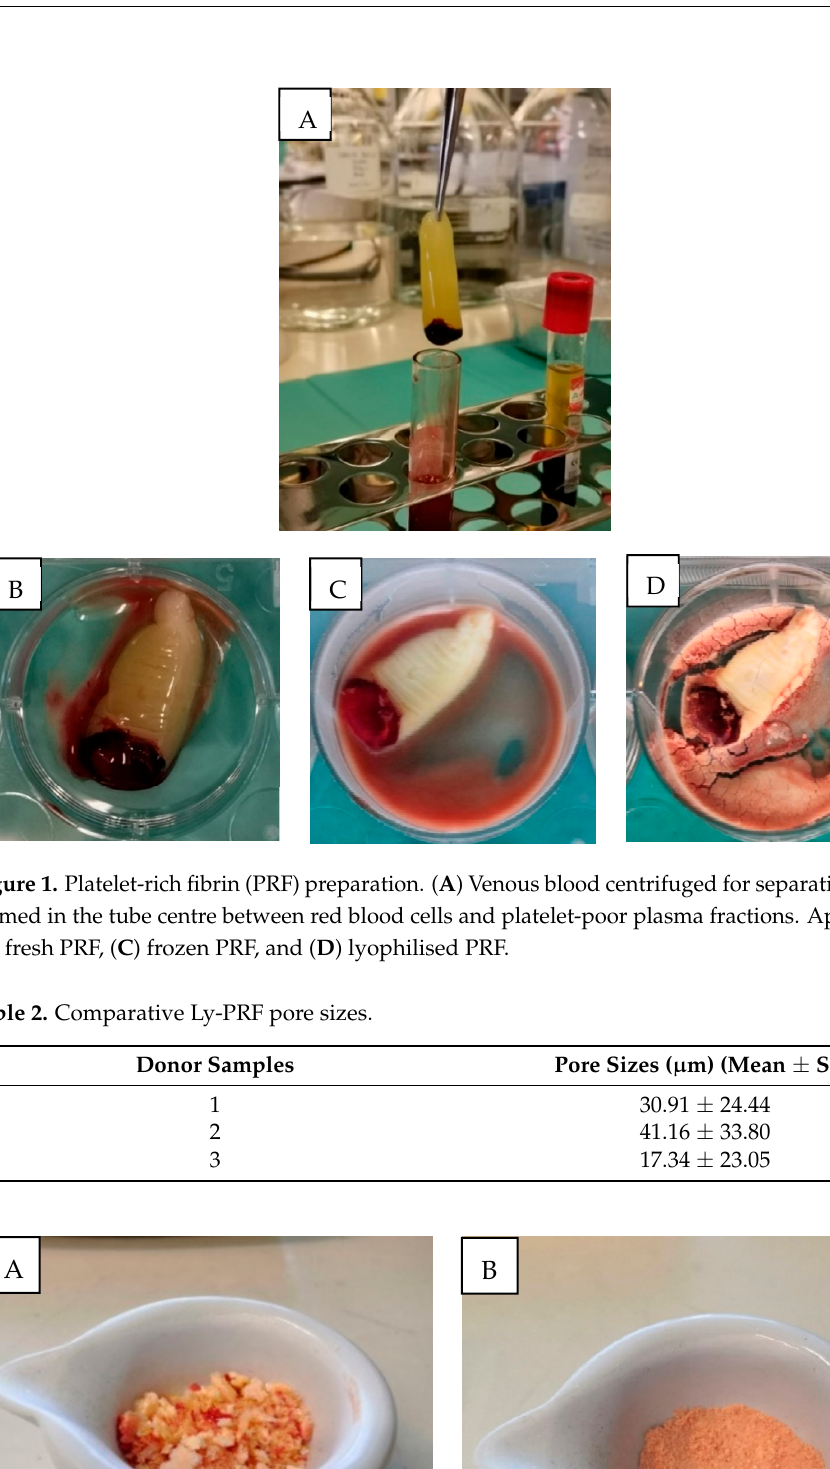
Figure 2. Physical appearance of lyophilised PRF. Ly-PRF ( A ) before and ( B ) after being ground into granules using a mortar and pestle. Table 2. Comparative Ly-PRF pore sizes.